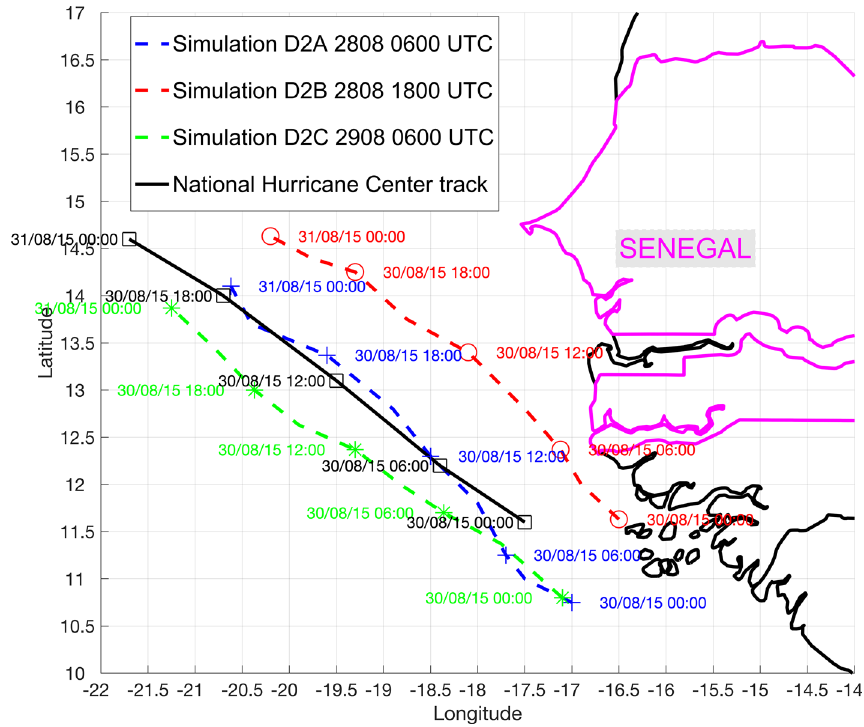
Figure 5a–f represents 10 m wind on 30 August 2015, respectively, at 0600 UTC and 2000 UTC. Simulated dis- turbances at 0600 UTC 30 August are located between 11 and 12.5 N in the three simulations (Fig. 5a, c, e). The simulated center of the disturbance in D2B is located closest to the coast (12.3 N, 17 W), while the center in D2C (11.7 N, 18 W) is located the furthest out to sea;